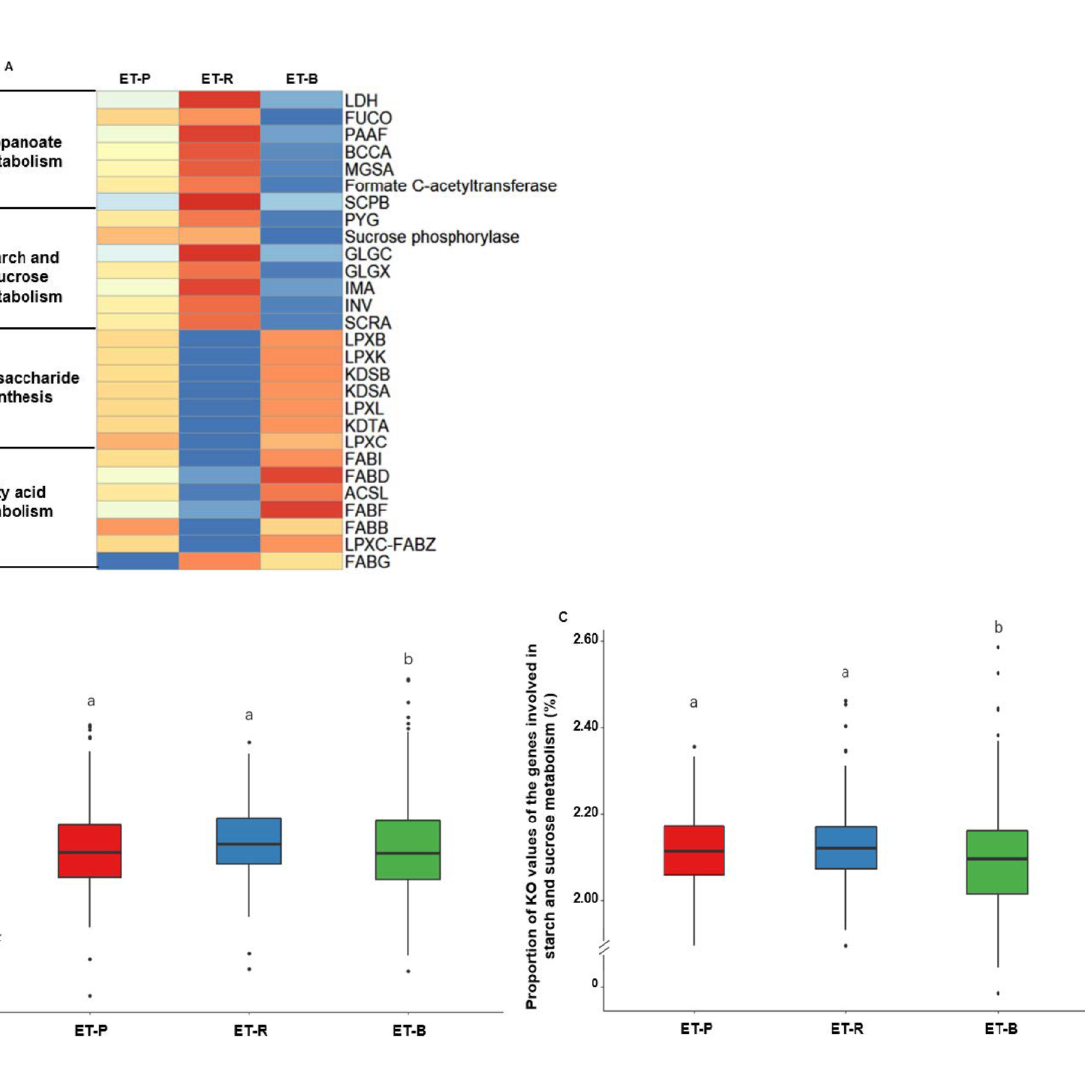
Figure 6. Heatmaps of abundant genes involved in metabolic functions determined by ( A ) PICRUSt2 and ( B – E ) the relative abundance of the genes related to significant metabolic functions in three enterotypes. ( A ) The association of the genes related to different functions in three enterotypes. ( B ) Propionate metabolism in three enterotypes. ( C ) Starch and sucrose metabolism in three enterotypes. ( D ) Lipopolysaccharide biosynthesis in three enterotypes. ( E ) Fatty acid metabolism in three enterotypes. LDH, L-lactate dehydrogenase; Figure 1. phosphate adenylyltransferase; GLGX, gly- cogen debranching enzyme; IMA, oligo-1,6-glucosidase; INV, beta-fructofuranosidase; SCRA, sucrose phosphoenolpy- ruvate-dependent sucrose phosphotransferase system permease component; LPXB, lipid-A-disaccharide synthase; LPXK, tetraacyldisaccharide 4′-kinase; KDSB, 3-deoxy-mannooctulosonate cytidylyltransferase; KDSA, 2-dehydro-3- deoxyphosphooctonate aldolase; LPXL, Kdo2-lipid IVA lauroyltransferase/acyltransferase; KDTA, 3-deoxy-D-manno- octulosonic-acid transferase; LPXC, UDP-3-O-(3-hydroxymyristoyl) N-acetylglucosamine deacetylase; FABI, enoyl-